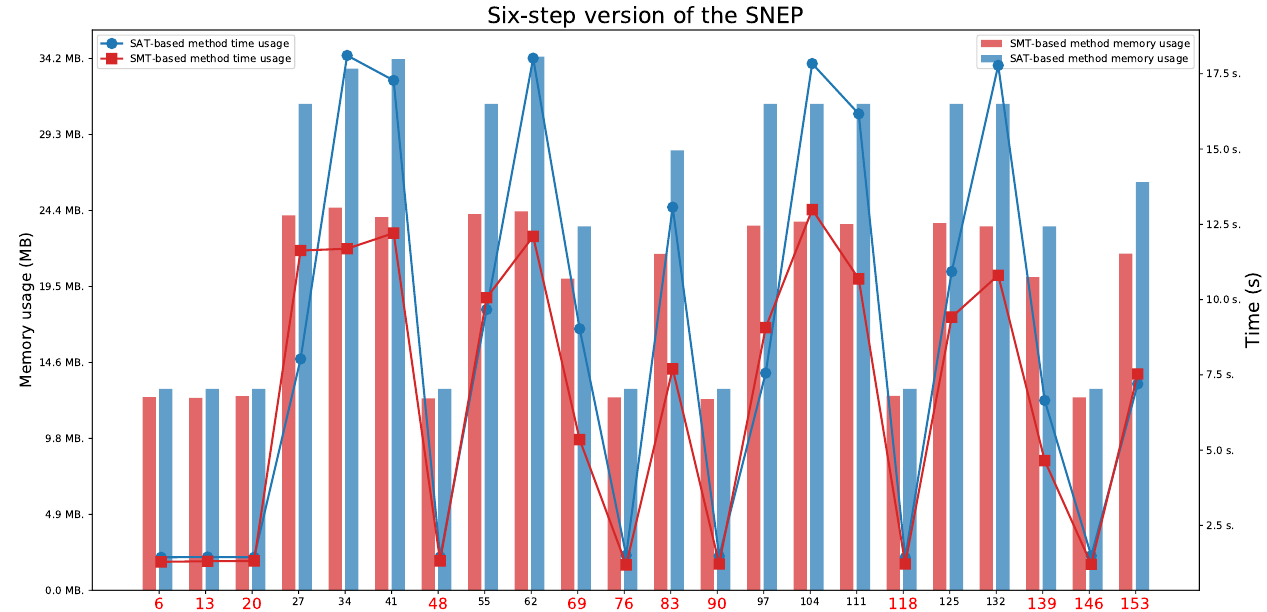
Figure 14. The six-step version of the SNEP: Time and memory usage for checking the last locations’ reachability in each execution automaton for lifetime values equal to 10. The reachable states are marked in